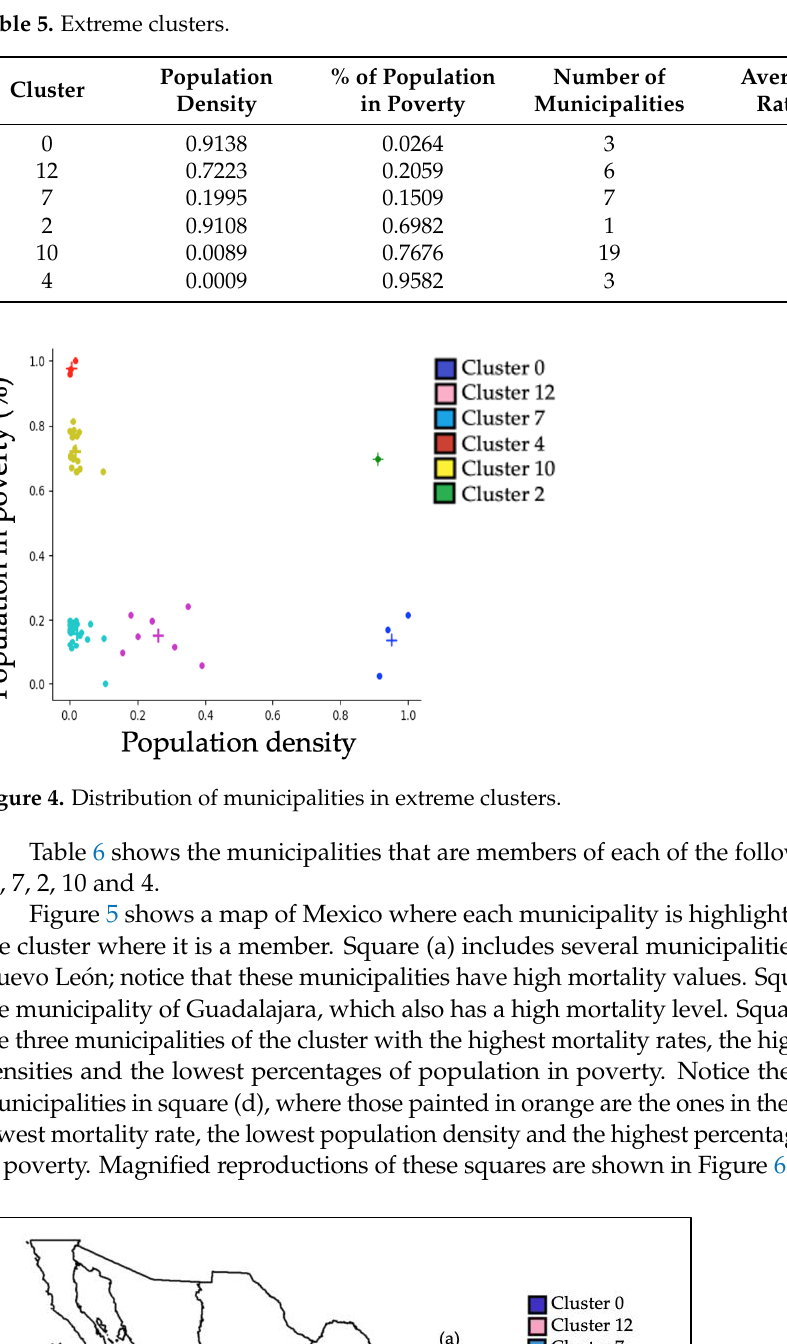
( d ) Figure 6. Magnified neighborhoods of municipalities. ( a ) Nuevo León. ( b ) Jalisco. ( c ) CDMX. ( d ) Chiapas. 3.2. Discussion The results of this study, through a methodology that combines the most relevant aspects of epidemiology within a Data Science framework, provide valuable information on clustering of the COVID-19 mortality according to sociodemographic factors at the municipal level in Mexico. This allows us to characterize the shapes of COVID-19